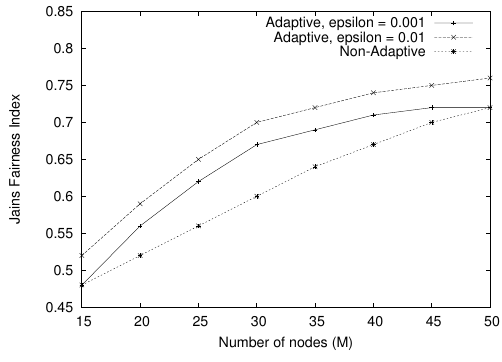
Figure 2: JFI (homogeneous case).